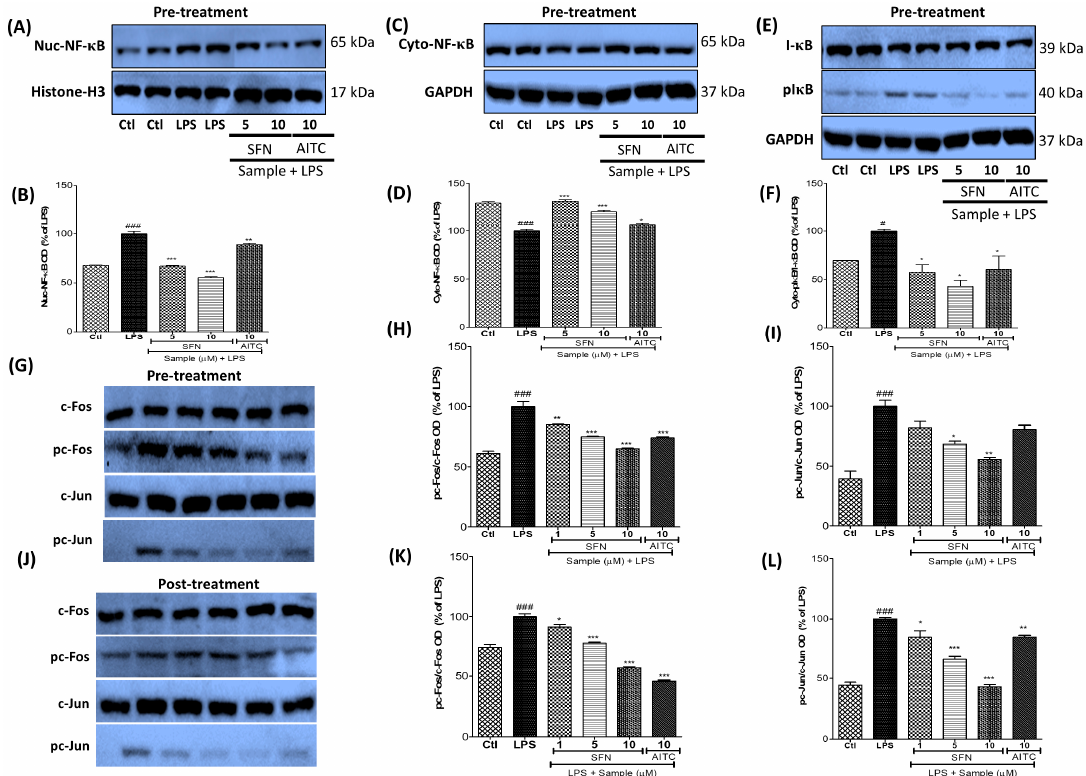
Figure 6. SFN inhibited NF- κ B translocation and I κ B phosphorylation, as well as AP-1 signaling,